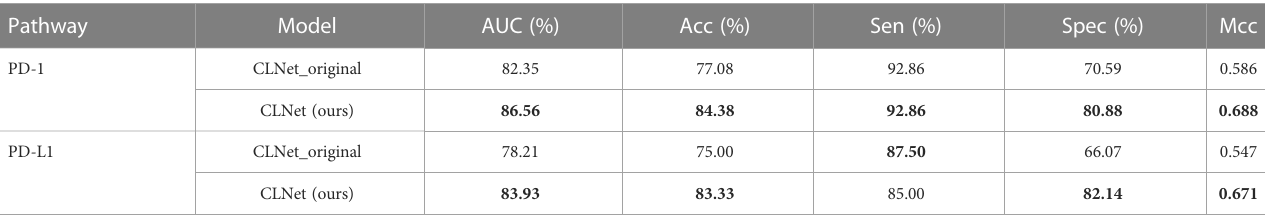
TABLE 4 Performance comparison between training with and without extra unlabeled CT images. Pathway